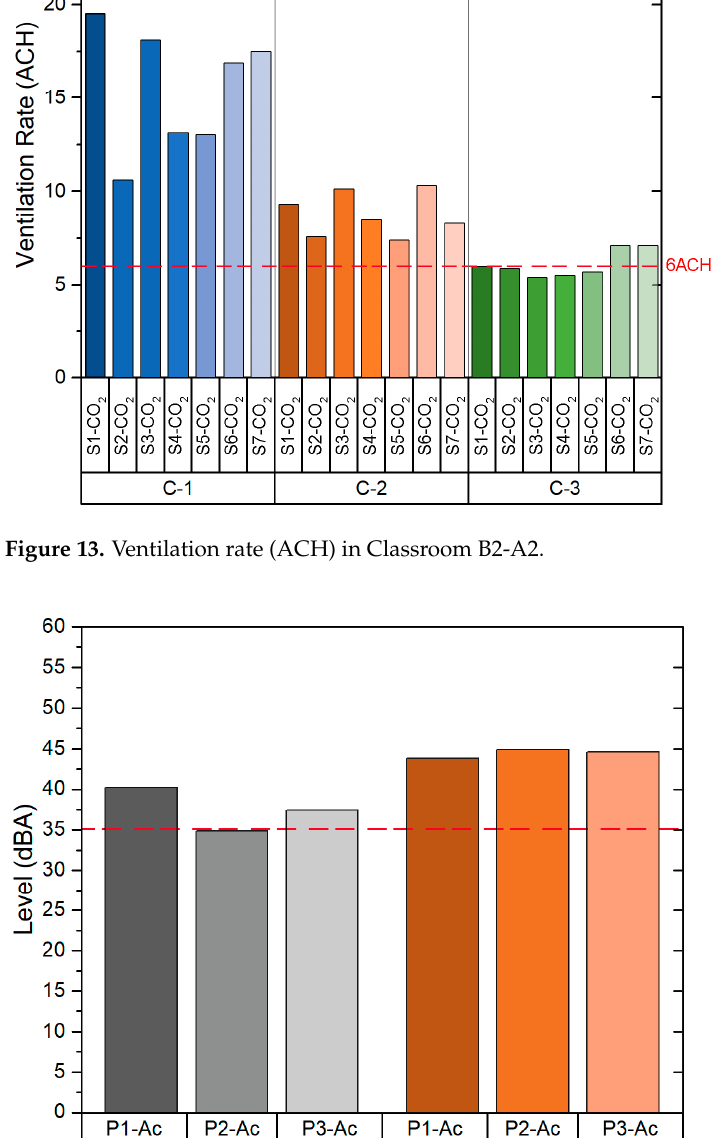
Figure 14. Background noise level in Classroom B2-A2.